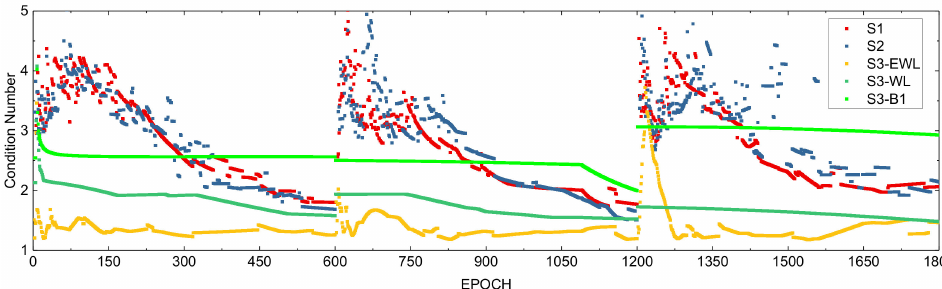
Figure 7. Number of conditions for ambiguity